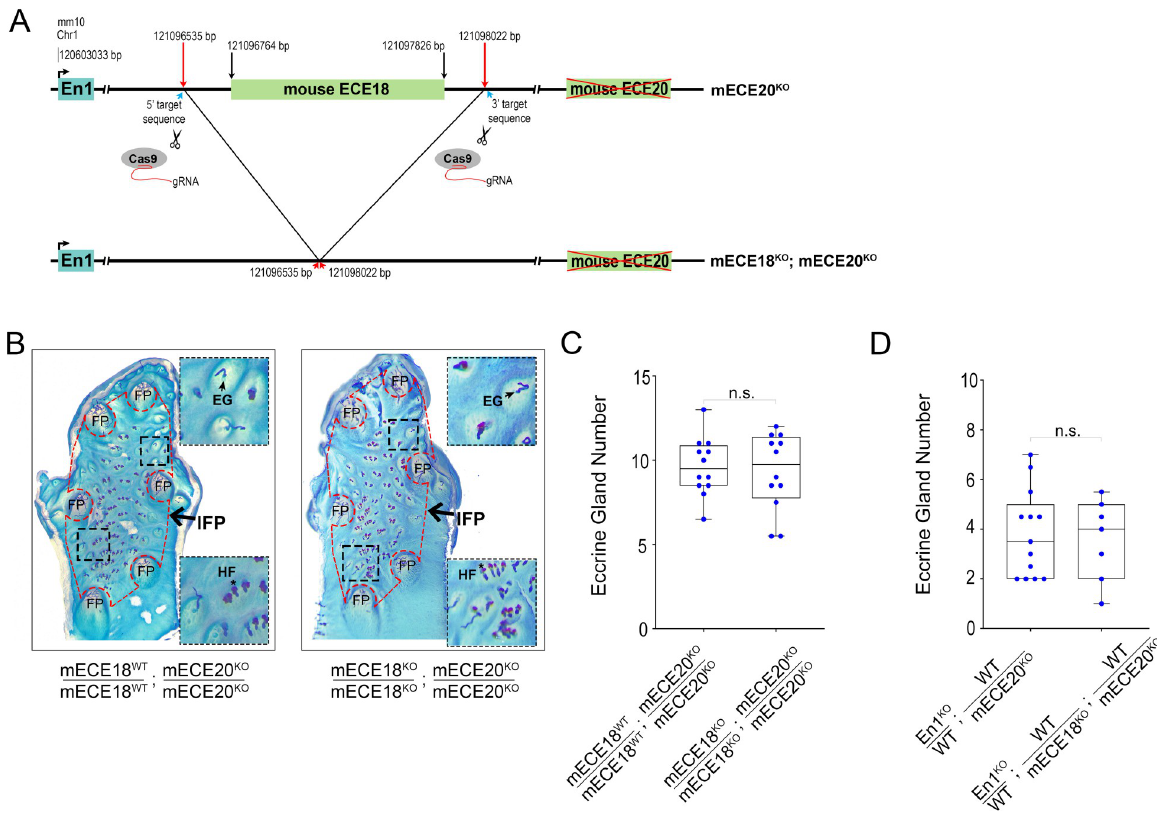
Fig 4. ECE20 is not redundant with ECE18 in the regulation of mouse eccrine gland number. (A) Strategy to generate mECE18; mECE20 (mECE18 KO ; mECE20 KO ) compound knock-out (KO) mouse. (B) Representative images of whole mount preparations of the volar hindlimb skin from mECE18 WT / mECE18 WT ; mECE20 KO / mECE20 KO and mECE18 KO / mECE18 KO ; mECE20 KO / mECE20 KO adult mice. Epidermal preparations were stained to facilitate quantification of appendages in the interfootpad area (IFP, outlined in red dashed border). Insets show magnified views of regions within the IFP (black dashed border). Footpad (FP), eccrine gland (EG) and hair follicles (HF). (C) Quantification of IFP eccrine glands in mECE18 WT / mECE18 WT ; mECE20 KO / mECE20 KO and mECE18 KO / mECE18 KO ; mECE20 KO / mECE20 KO mice. (D) Quantification of IFP eccrine glands in En1 KO / WT; WT / mECE20 KO and En1 KO / WT; WT / mECE18 KO ; WT / ECE20 KO mice. In (C, D) each point represents the average number of eccrine glands in the IFP across both hindlimbs of a mouse. In (C, D) significance assessed by a two-tailed T-test. n.s. not significant. (KO) knock-out. The median (line) and maximum and minimum are reported for each genotype. See also S4